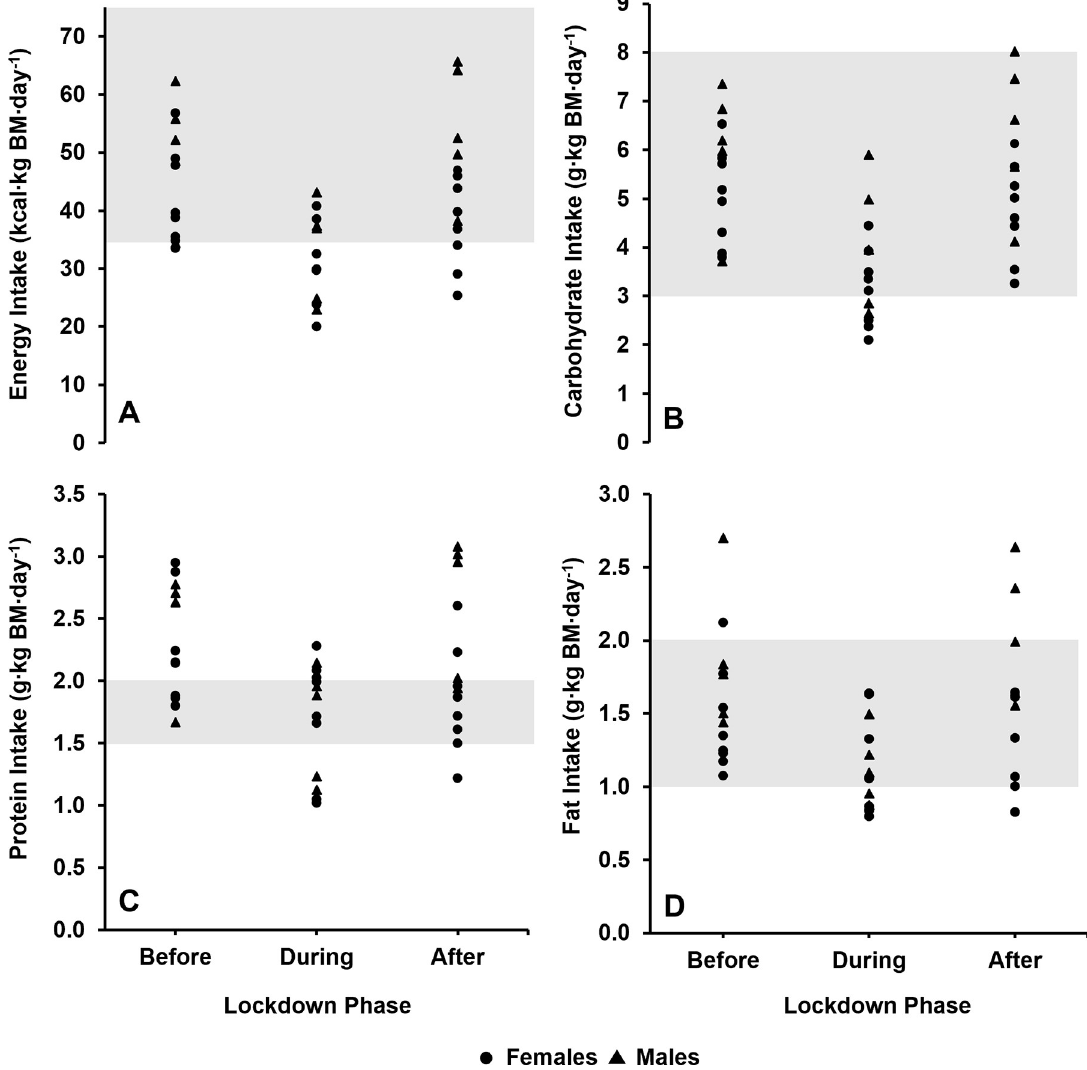
Fig 1. The relative energy and macronutrient intakes of each individual swimmer before, during, and after the COVID-19 lockdown. Grey shaded areas represent the recommended nutritional intakes for swimmers based upon: A) energy intake [7], B) CHO intake [7], C) protein intake [7], D) fat intake [10].